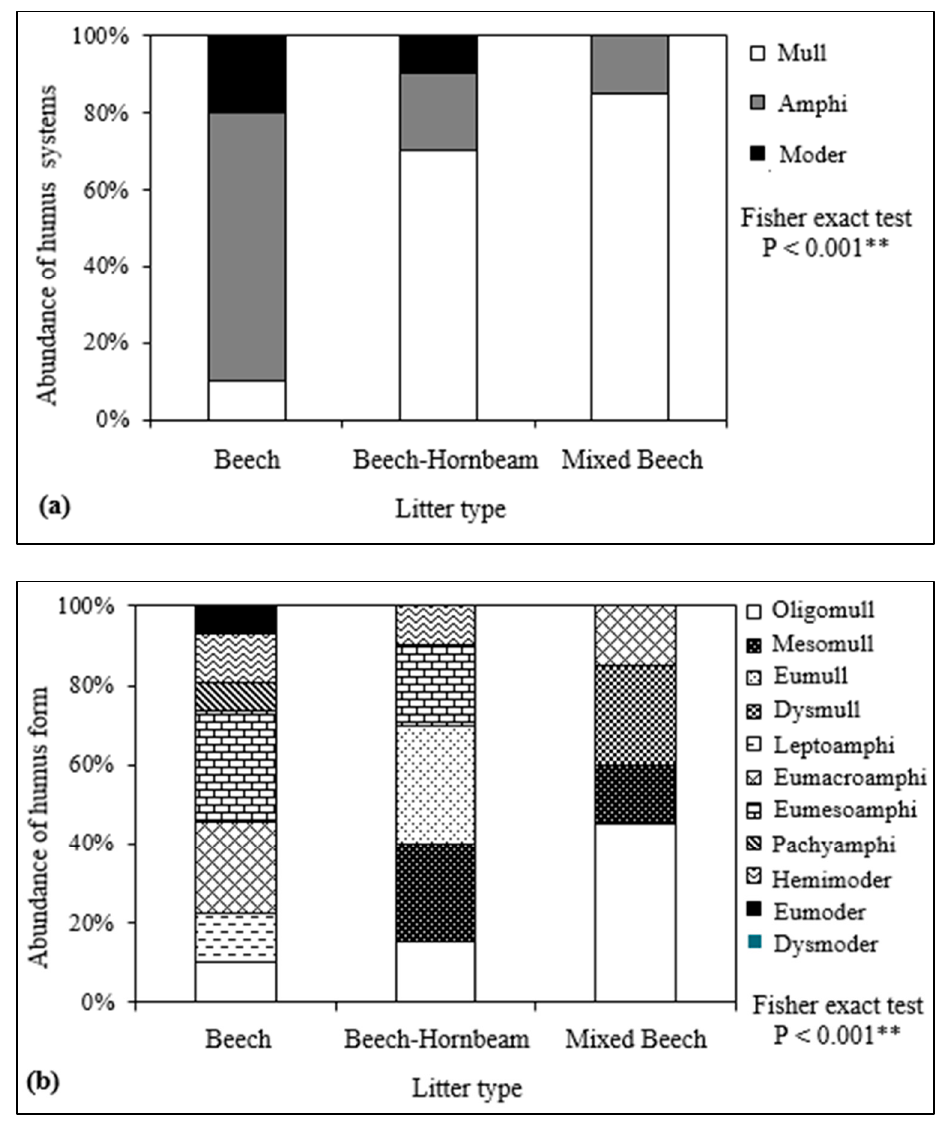
Figure 3. Abundance of humus systems ( a ) and humus forms ( b ) in relation to different Litter types. The system (Figure 4a) and the humus form (Figure 4b) had a more uniform composition with an increase in the age of the skid trail. Three types of mull, amphi, and moder humus were observed in the 6-year skid trail, while mull and amphi humus were observed 20 years after the logging operations in the skid trail (Figure 4a). Oligomull was the most common form of mull humus in skid trails, and its highest abundance was observed in the 20-year-old skid trail. Mesomull, eumull, and Dysmull were other forms of mull humus that were observed in mixed beech and beech-hornbeam litter treatments. Eumesomphi was the most common form of amphi humus in the skid trails, and their highest frequency was observed 6 years after logging operations. Eumacroamphi and leptoamphi were among the other forms of amphi humus in all three skid trails. Hemimoder was observed as the most common form of moder humus in the 6 and 10-year skid trails, which were present along with eumoder and dysmoder in these routes (Figure 4b).